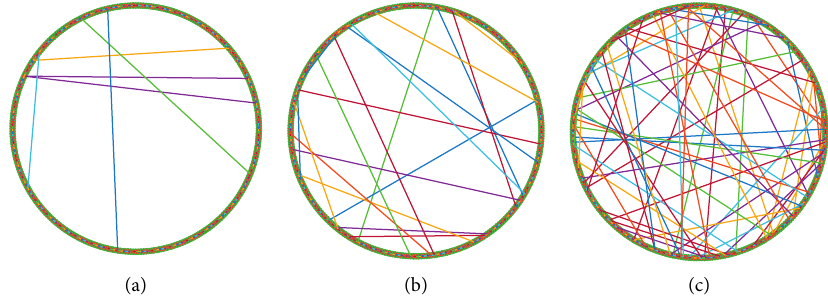
Figure 17: Small-world network ( p � 0 . 01 , 0 . 05 , 0 . 1). (a) p � 0 . 01, (b) p � 0 . 05, and (c) p � 0 . 1.